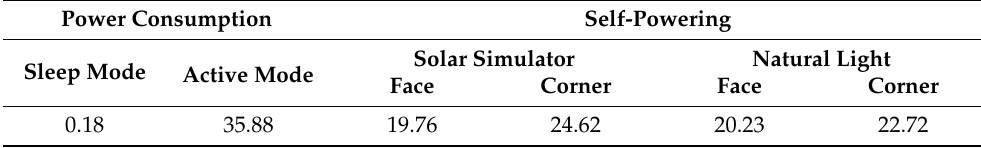
Table 2. Self-power performance testing